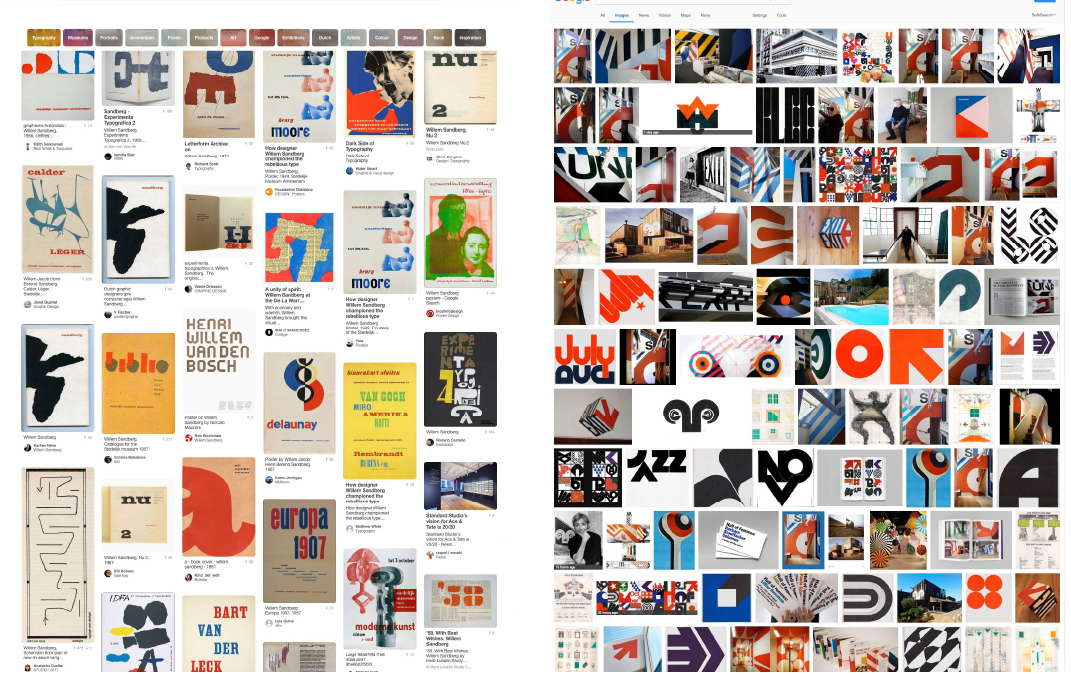
Figure 3. On the left, Pinterest search result, keywords: “Willem Sandberg”. On the right: Google Images search result, keywords: “Barbara Stauffacher Solomon”